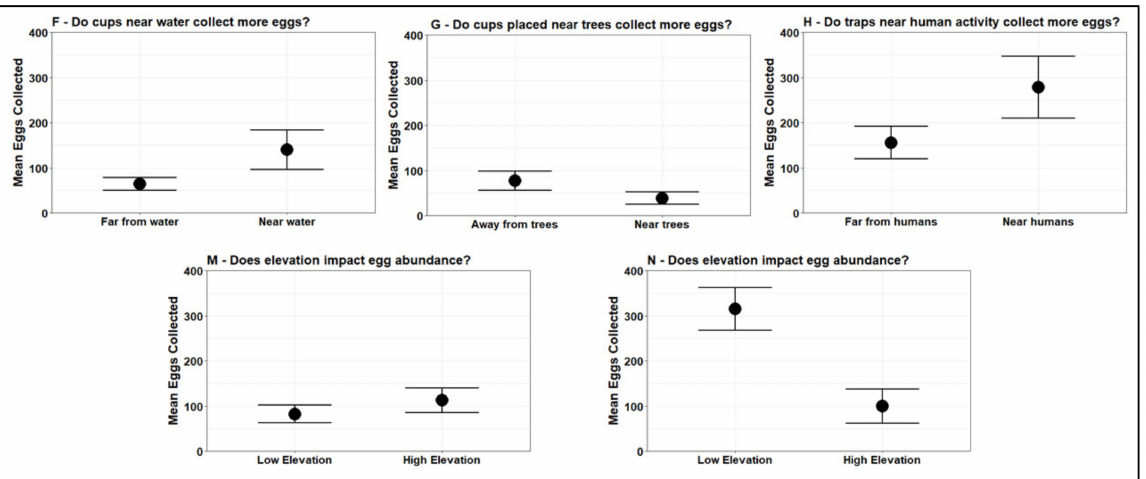
Figure 2. Results of student-driven inquiries from five participating schools in 2020. Schools are anonymously denoted with unique letters (F, G, H, M, and N).